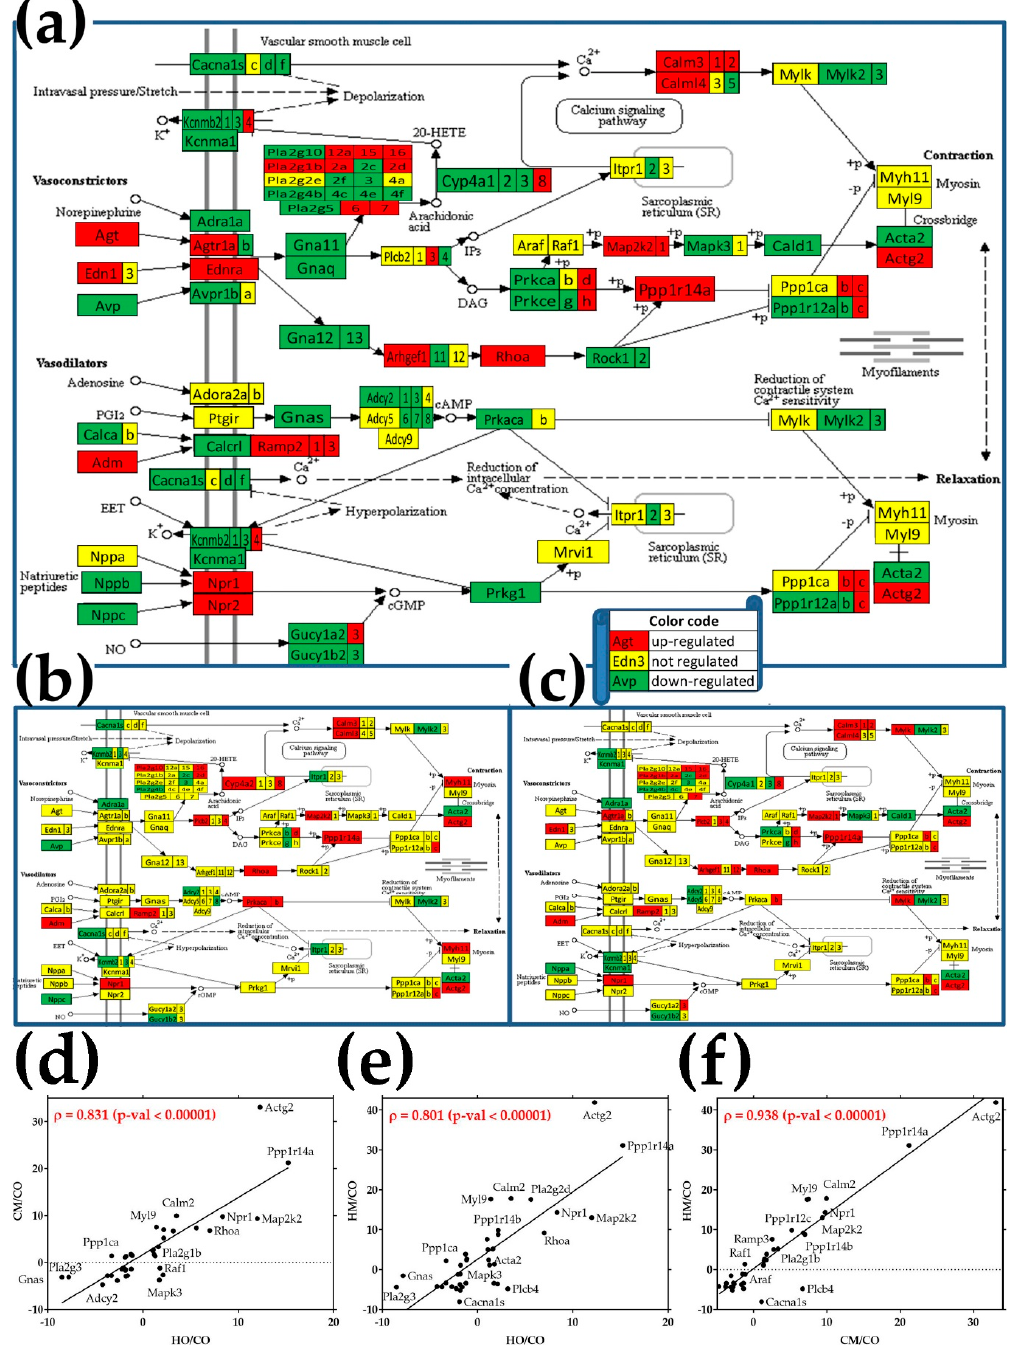
Figure 3. Regulation of the vascular smooth muscle contraction pathway. ( a ) Rats treated with monocrotaline (MCT) and exposed to hypoxia (HM); ( b ) rats exposed to only hypoxia (HO); ( c ) rats treated with monocrotaline only (CM). Regulated genes: Acta2 (smooth muscle α -actin), Actg2 (actin, γ 2, smooth muscle, enteric), Adcy2 (adenylate cyclase 2), Adora2a (adenosine A2a receptor), Agtr1a (angiotensin II receptor, type 1a), Ang (angiogenin), Araf (v-raf murine sarcoma 3611 viral oncogene homolog), Avp (arginine vasopressin), Cacna1d/s (calcium channel, voltage-dependent, L type, α 1D/S subunit), Cald1 (caldesmon 1), Calm2 (calmodulin 2), Cyp4a1/8 (cytochrome P450, family 4, subfamily a, polypeptide 1/8), Gnas (GNAS complex locus), Gucy1b2 (guanylate cyclase 1, soluble, β 2), Itpr1